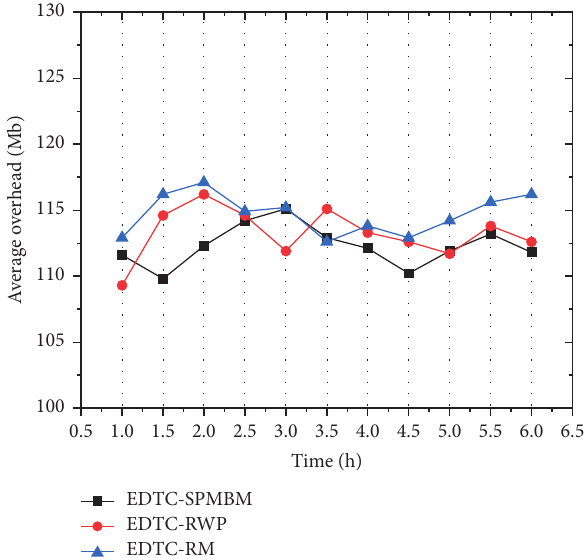
Figure 21: Relationship between average delay and time in three mobile models.